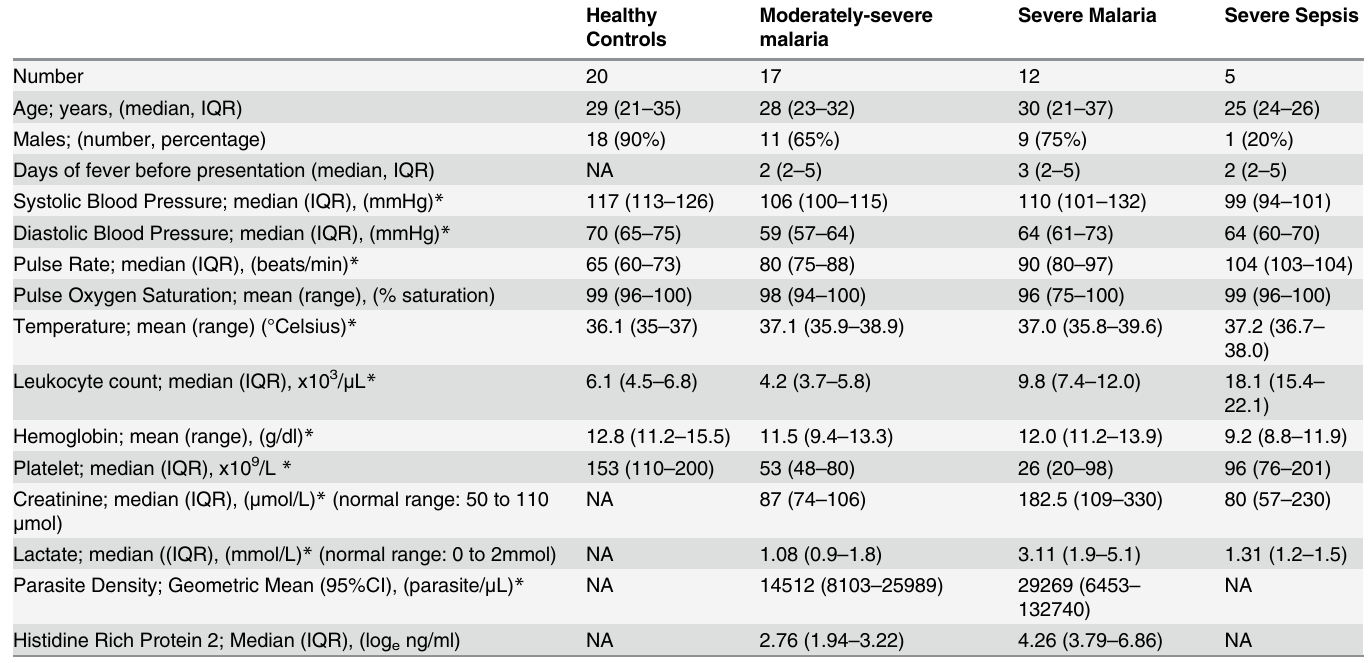
Table 1. Baseline demographics, clinical and laboratory